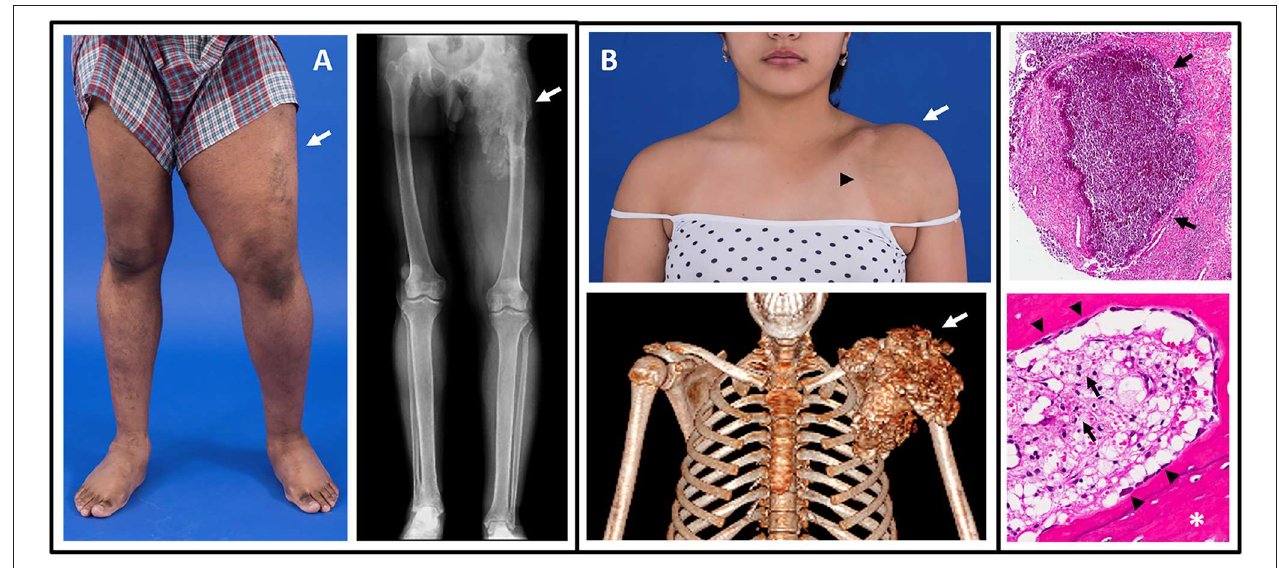
FIGURE 1 | Images of tumoral calcinosis lesions. (A) Photograph (left panel) of a patient with swelling and decreased range-of-motion of the left lower extremity (arrow). The corresponding radiograph (right panel) shows a large area of tumoral calcinosis involving the left proximal femur. (B) Photograph (upper panel) of a patient with painful swelling and reduced range-of-motion of the left shoulder (white arrow). Note the overlying skin pigmentation and increased vascularity (black arrowhead). A corresponding three-dimensional computed tomography scan shows a large calcified mass involving the left shoulder (arrow). (C) Hematoxylin and eosin stained sections from resected tumoral calcinosis lesions. The upper panel shows a subcutaneous calcification (arrows). The lower panel shows heterotopic ossification (white asterisk) with active osteoblasts laying down new bone (black arrowheads). Note the presence of chronic inflammation with visible foamy macrophages (black arrows). These figures are original, and have not been previously published or obtained from a private database. There is no unpublished data in any of the